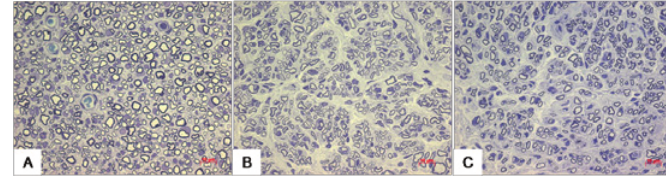
FIGURE 5 - Photomicrographs showing harvested nerve after eight weeks of surgery. The samples were embedded in resin and named: related to implant M1 ( A ), related to implant M2 ( B ), and distal to implant ( C ). There is a great number of myelinated fibers within the nerve related to implant, just like the distal to implant. Toluidine Blue stain. Objective magnification: